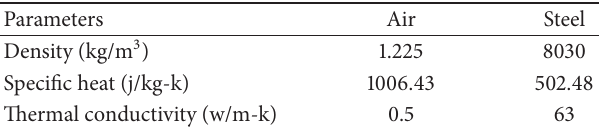
Table 1: Parameters of air and steel.